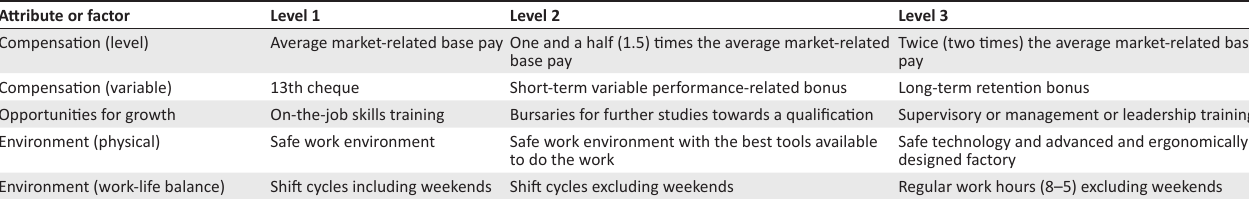
TABLE 4: Conjoint task for artisans. Attribute or